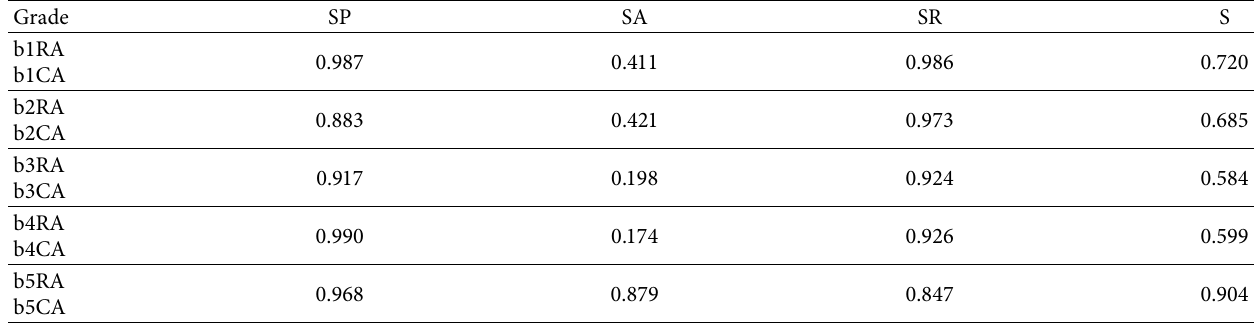
Figure 10: Scatter plot of (a) x -coordinate; (b) y -coordinate; (c) area; (d) Table 6: Estimation of shape similarity.